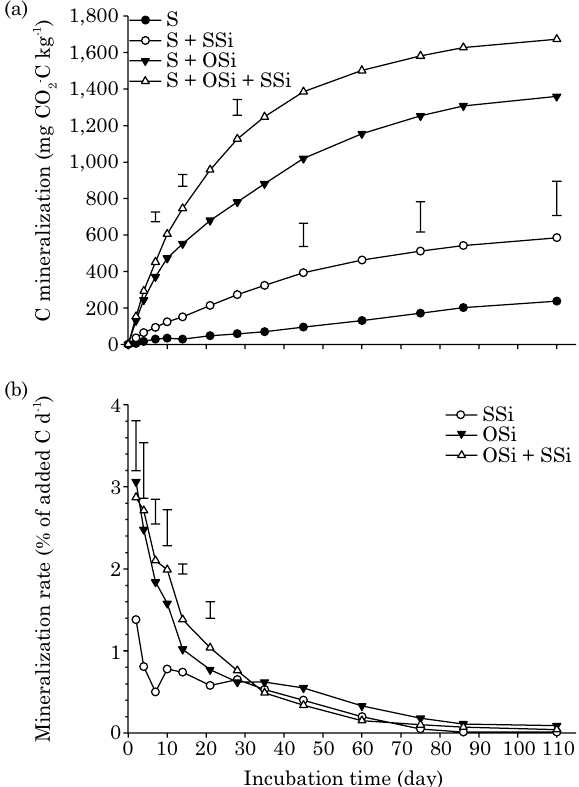
Figure 1. Cumulative C mineralization (a) and mineralization rate (b) during the incubation of sewage sludge (SS) and oat straw (OS) incorporated (i) into soil (S) combined or alone. Vertical bars represent the minimum significant difference between treatment means (Tukey at 5